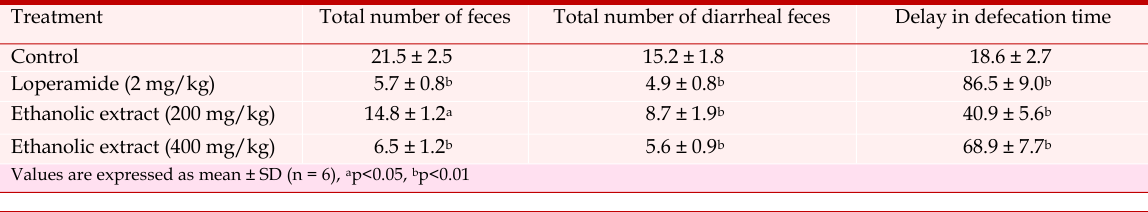
Evaluation of anti-diarrheal activity of ethanolic extract of D. malabarica by castor oil-induced diarrhea Treatment